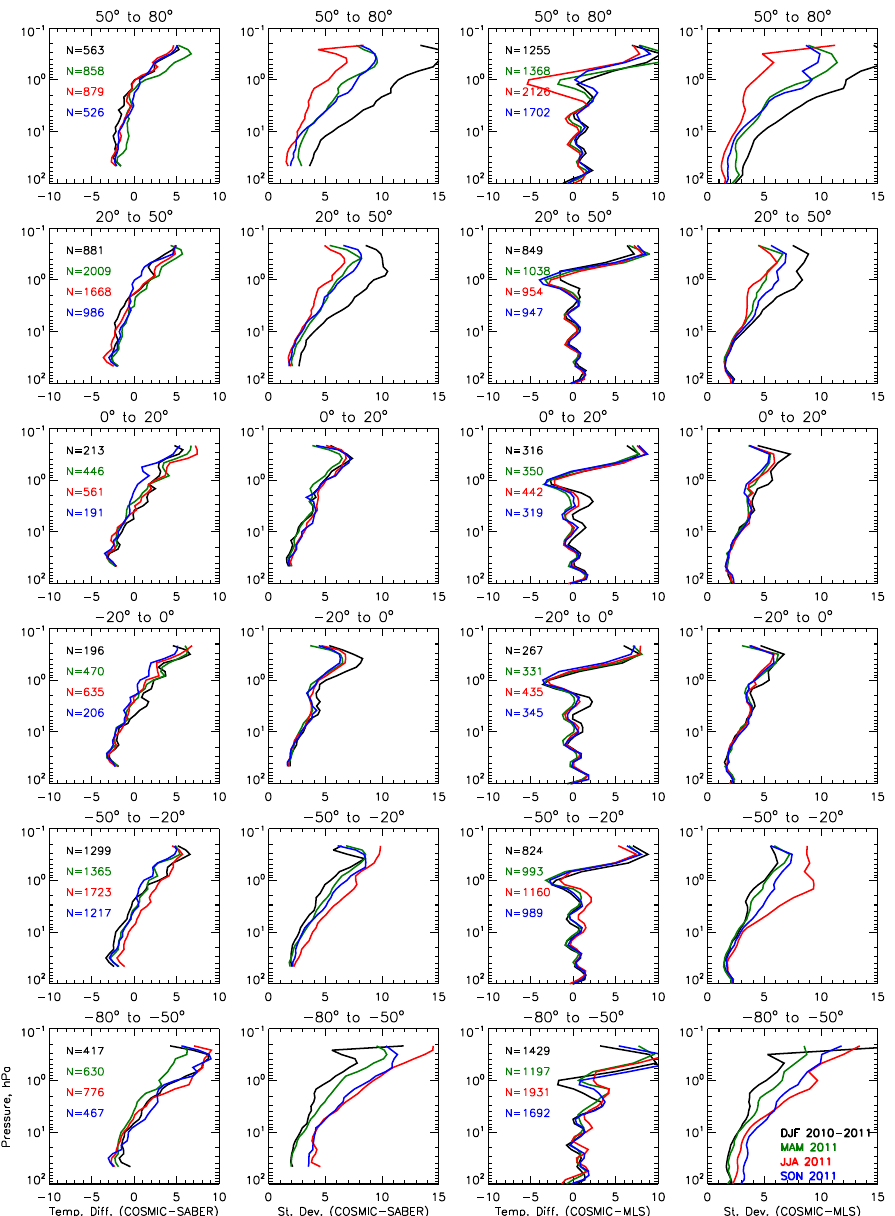
Fig. 2. Seasonal median differences between COSMIC & SABER and COSMIC & MLS temperatures obtained from near simultaneous observations in space and time (columns 1 and 3) and the corresponding standard deviations (columns 2 and 4) in different latitudinal regions (rows) and during different seasons (profile